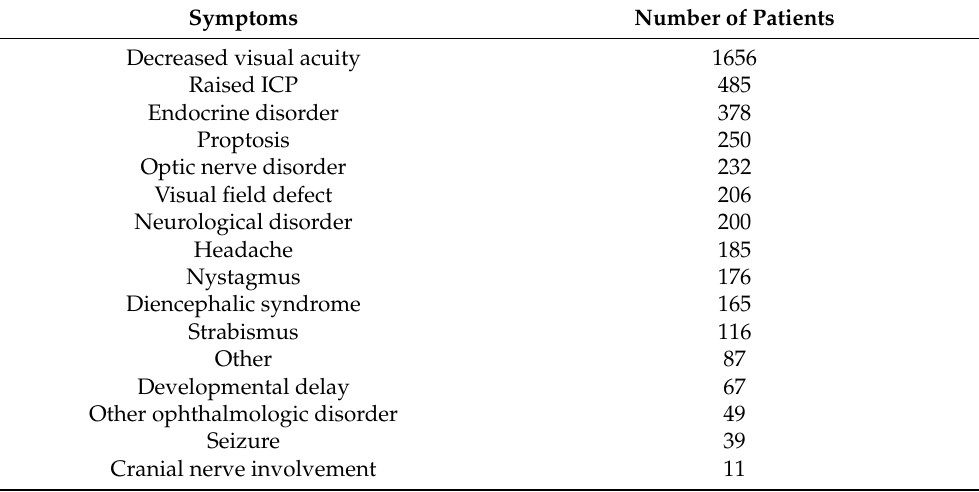
Table 1. The reported symptoms and their frequency among the patients with OPG.